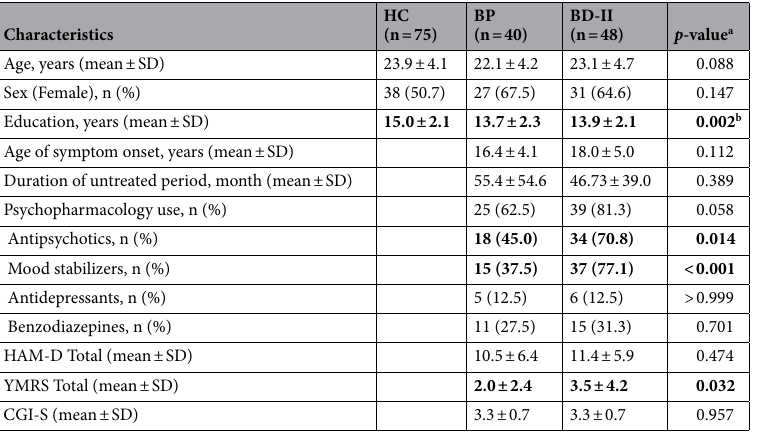
Table 1. Demographic and clinical characteristics of the study subjects. Significant values are in bold. a Significant differences between the healthy control, bipolar prodrome, bipolar II disorder samples were examined using the chi-square test for categorical variables, and analysis of variance (ANOVA) and independent samples t-test for continuous variables. b HC showed longer duration of education when compared to BP and BD-II group. HC Healthy control, BP Bipolar II prodrome, BD-II Bipolar II disorder, SD Standard deviation, BMI Body mass index, HAM-D Hamilton depression rating scale, YMRS Young mania rating scale, CGI-S Clinical global impression-severity